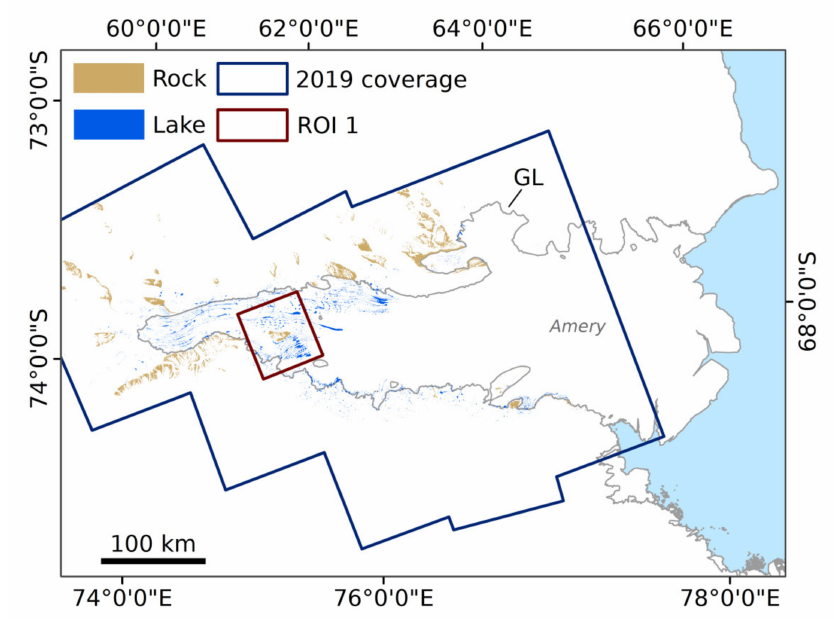
Figure 10. Maximum lake extent and rock outcrop map for the full Sentinel-2 coverage during the 2019 melt season over Amery Ice Shelf, Antarctica. Table 5. Supraglacial lake occurrence within defined geographical units on Amery Ice Shelf